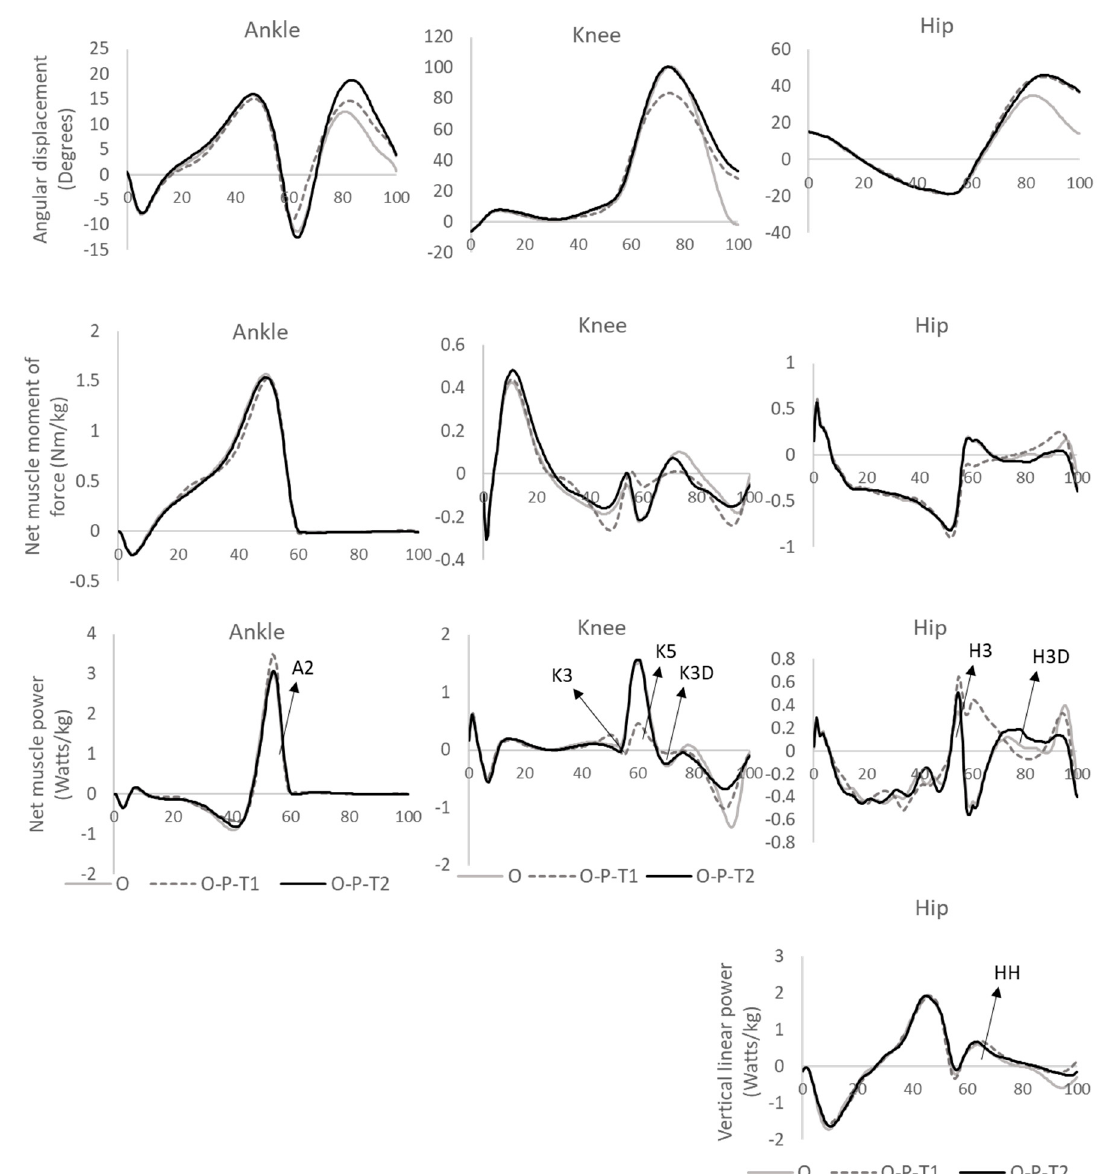
Figure 2. Average plots of angular displacement (top), net muscle moment of force (middle) and net muscle power (bottom) at the ankle (left), knee (middle) and hip (right) joints of the trailing limb during unperturbed conditions (gray line), and perturbations of obstacle to platform at T1 (O-P-T1; dashed line) and T2 (O-P-T2; black line). Gait stride was normalized to 100% with toe-o ff fixed at